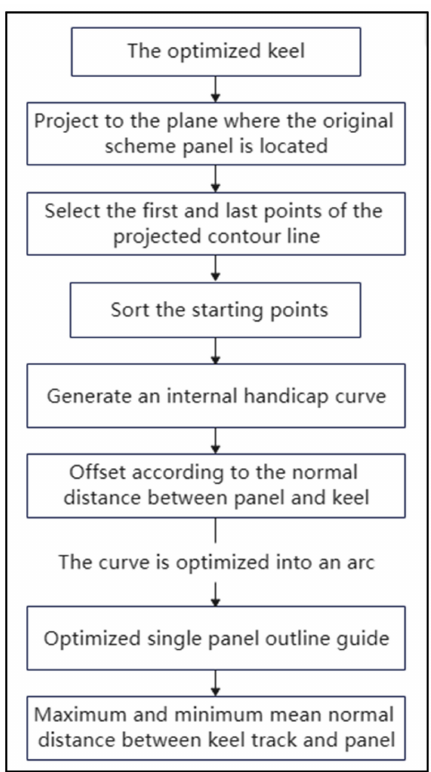
Figure 2. Panel optimization process in the comprehensive optimization